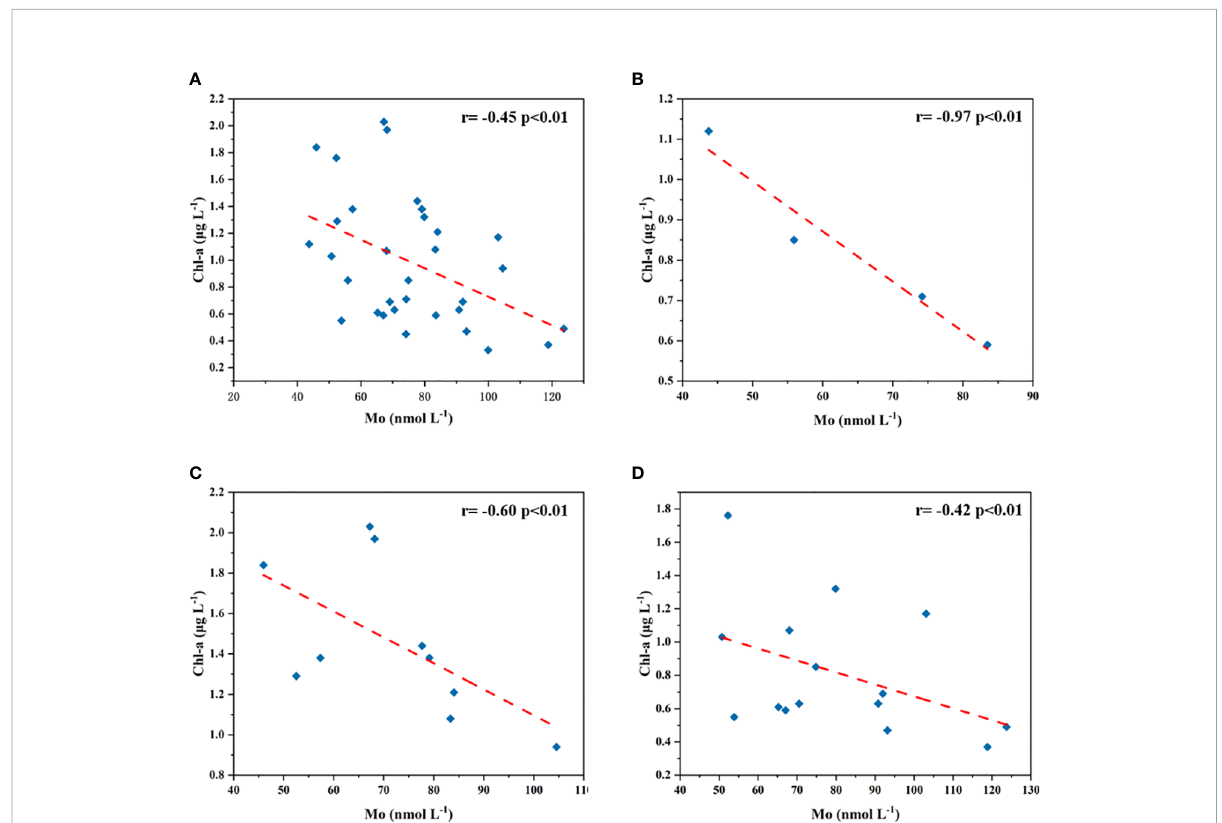
FIGURE 9 Correlations of dMo with Chl- a in the BS and YS (A) , the BS (B) , the NYS (C) and the SYS (D)